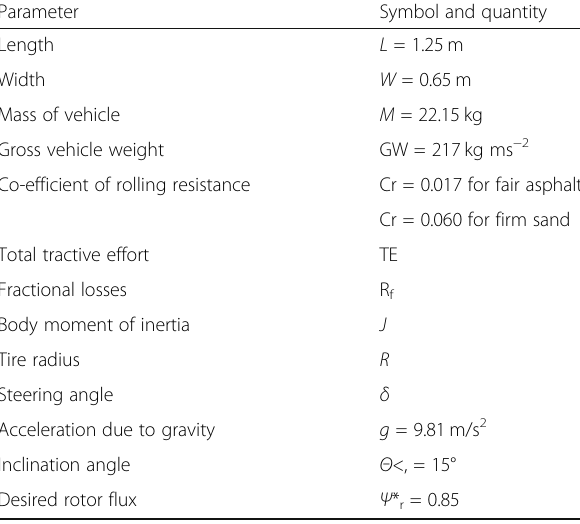
Table 1 Vehicle parameters, symbols, and quantities